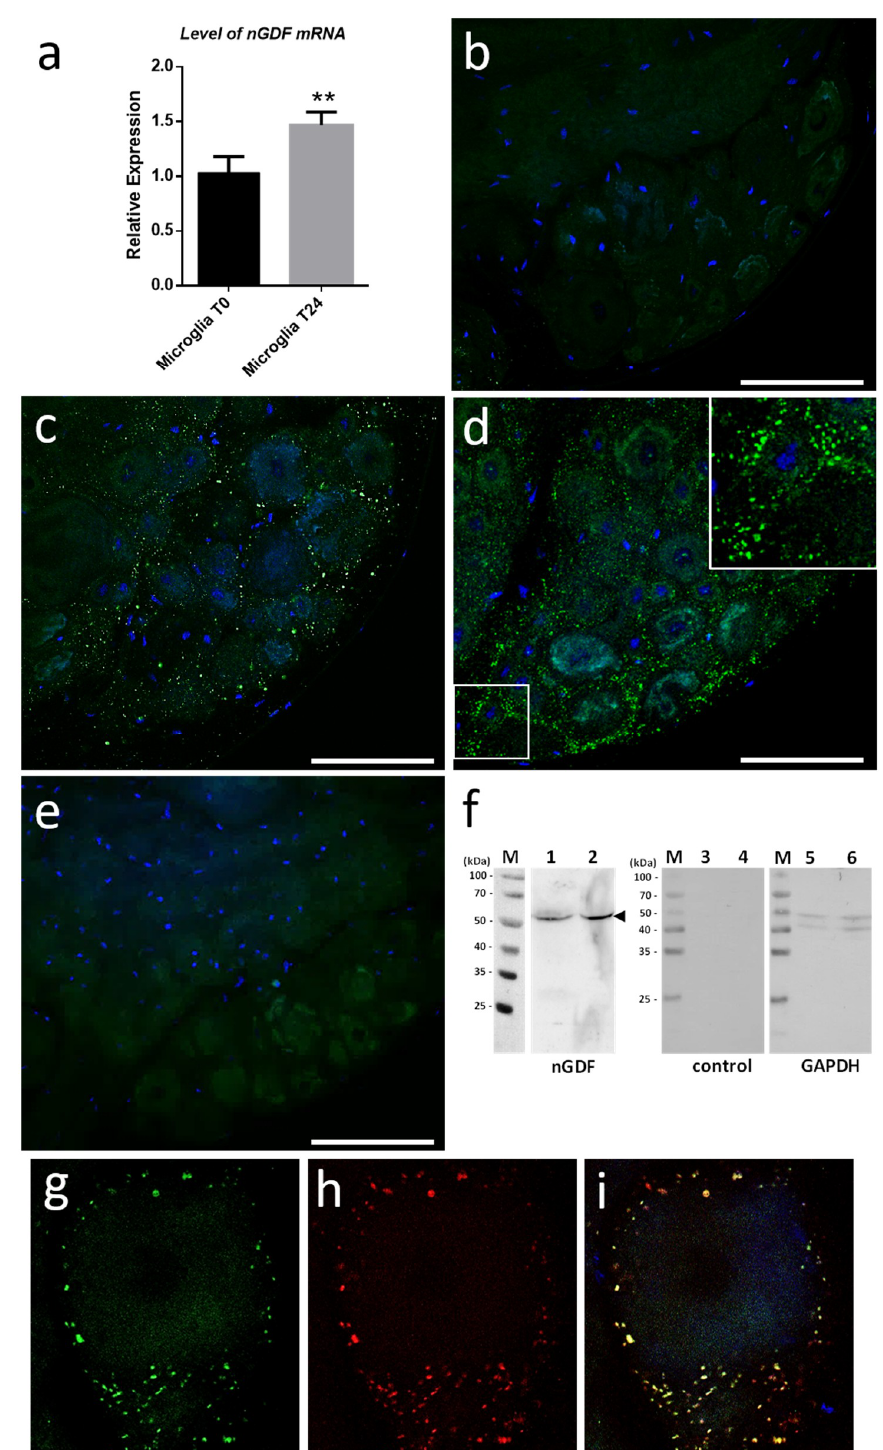
Figure 7. Induction of ngdf mRNA level and immunolocalization of nGDF protein. ( a ) q-PCR results indicate that ngdf mRNA is present in freshly dissociated (T0h) microglial cells and significantly increases in cultured microglia (T24h). Significance (** p < 0.01) was calculated by ANOVA paired t - test (bar represents standard errors of mean). ( b – e ) Confocal immunofluorescence analyses using rabbit polyclonal anti-human TGF-β1 antibodies on nerve cords freshly dissected (T0h) ( b ) or